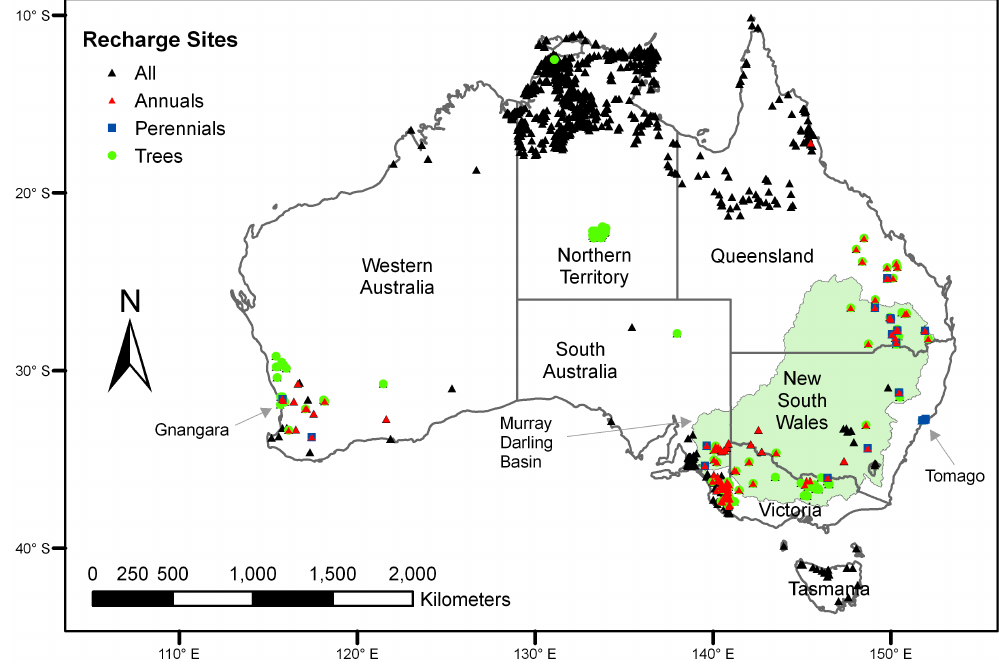
Fig. 1. Location of field sites where recharge has been measured also showing where the different vegetation types were recorded. The class “all” is all the recharge estimates irrespective of vegetation